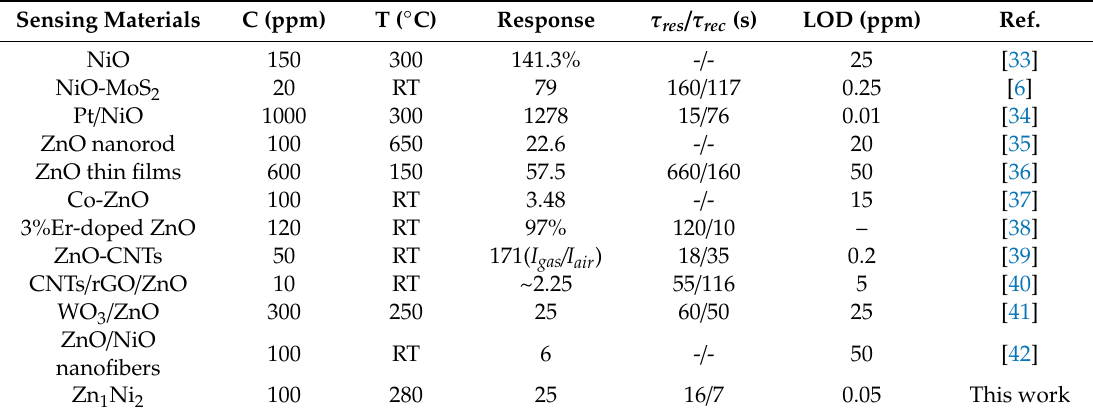
Table 1. Comparison of the sensing performance of various gas sensors toward NH 3 .